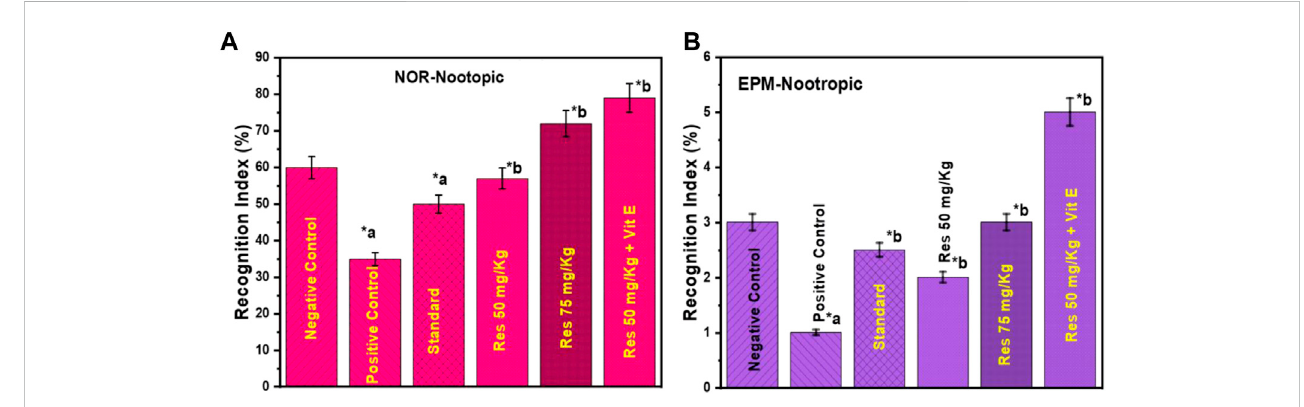
FIGURE 2 Behavioural analysis in rats (A) recognition indices in NOR for the nootropic model and; (B) in fl ection ratios in EPM for the nootropic model. a negative control vs. positive control; b positive control vs. treatment groups.